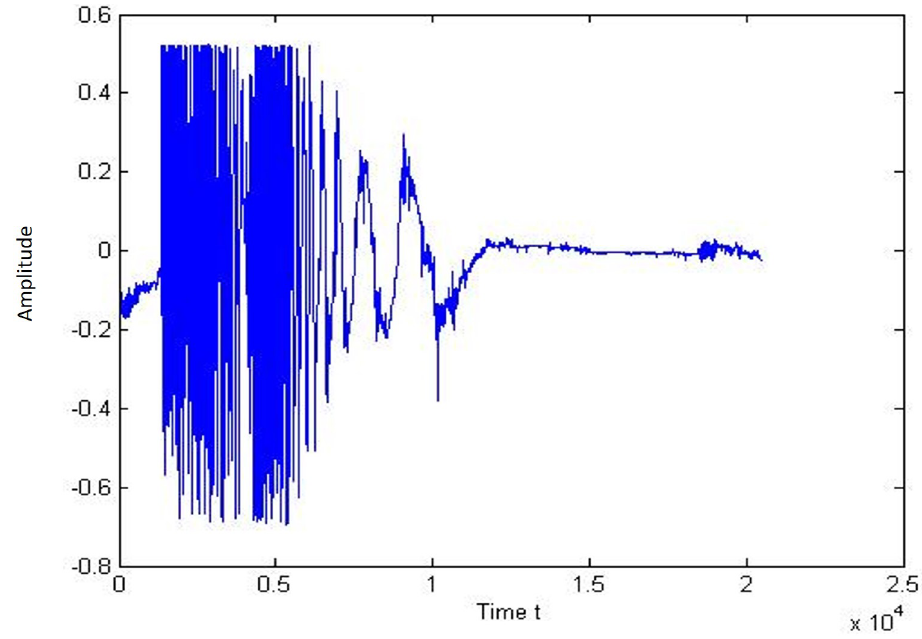
Figure 20. Plot of signal for jump of single